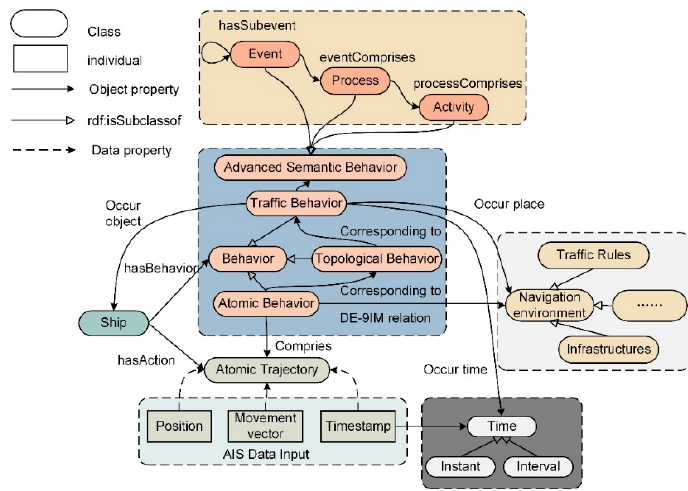
Figure 3. Ontology model of cognition for ship behavior.